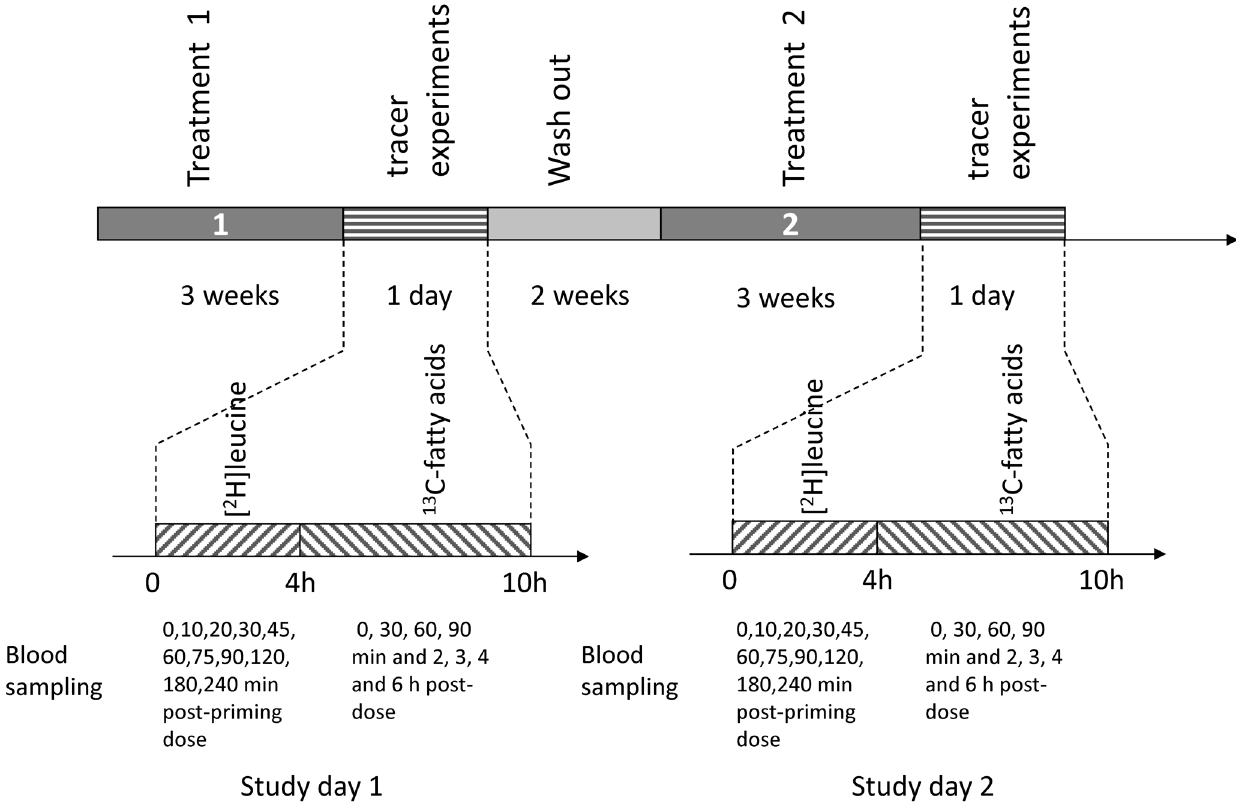
Figure 1. Schematic overview of the test day. doi:10.1371/journal.pone.0100376.g001 PLOS ONE |